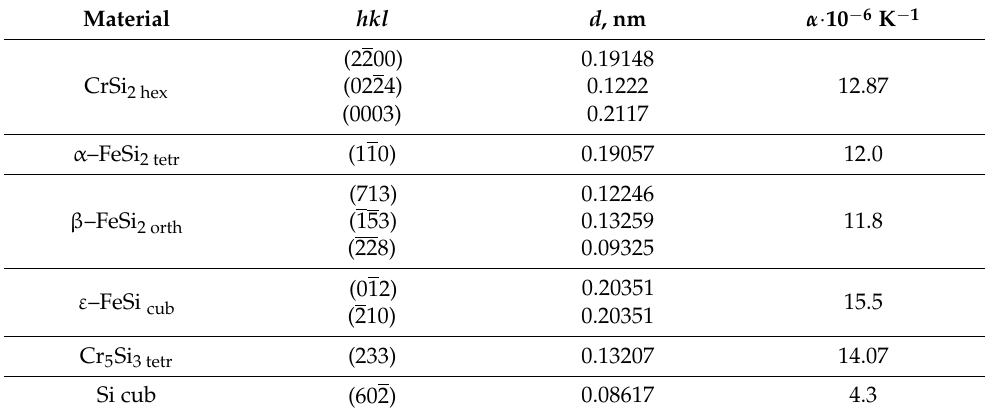
Table 3. Planes and corresponding interplanar spacings d , thermal expansion coefficients [23,59–62] to derive the lattice mismatch from orientation